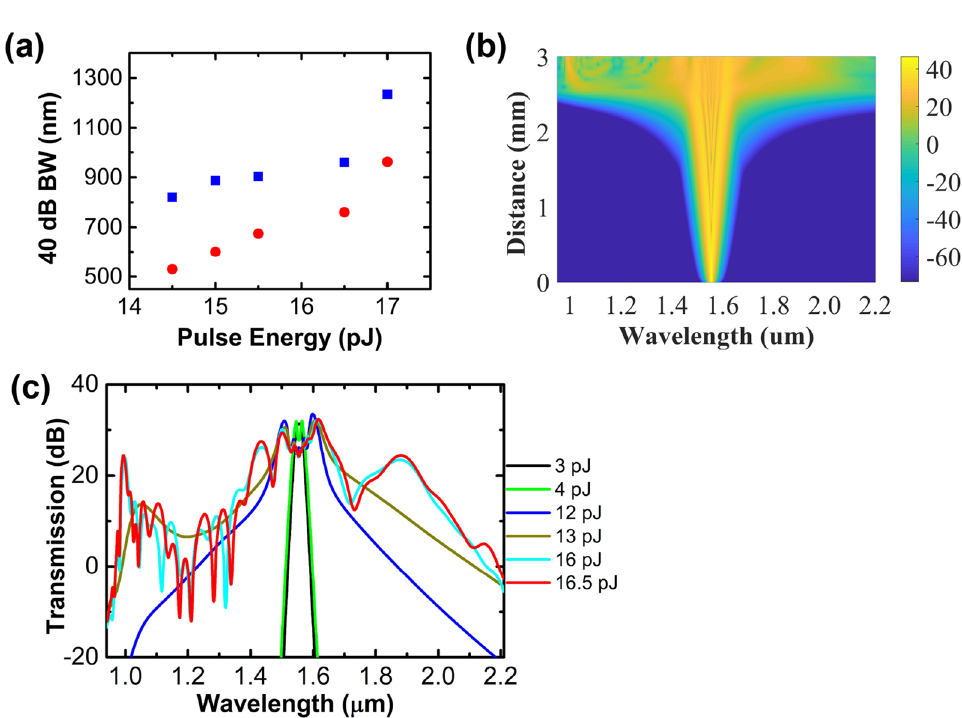
Figure 3. ( a ) Experimentally measured 40 dB bandwidth at various input pulse energies, where the blue data are obtained based on the SCG span within the –40 dB level edges, while the red data are obtained based on the SCG span after subtracting components below the –40 dB level. ( b ) Simulated pulse dynamics using 500 fs pulses in the USRN waveguide. ( c ) Simulated output spectra at various pulse energies coupled into the USRN